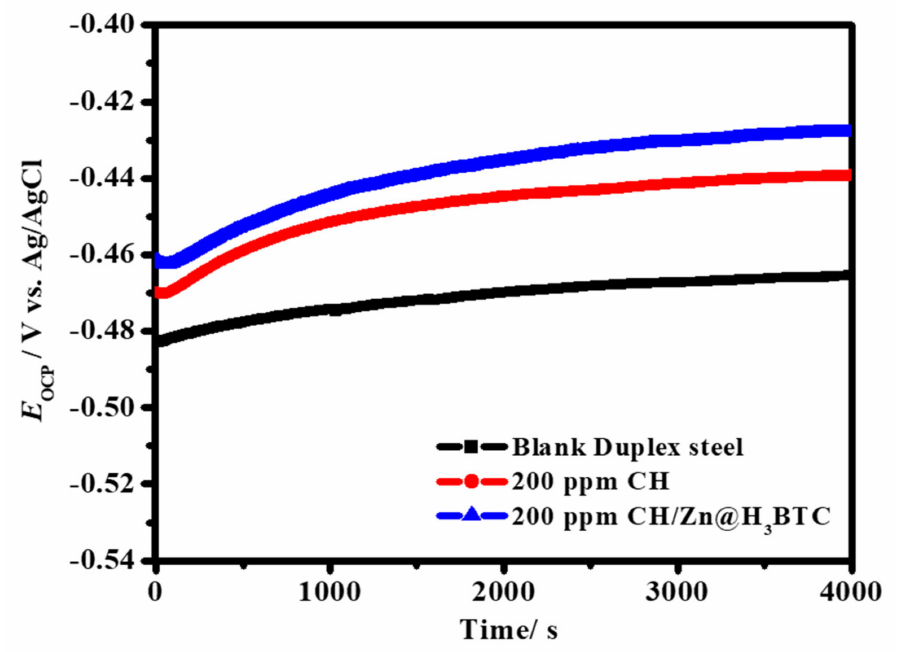
Figure 5. E OCP versus t profiles for duplex steel in a 2.0 M sulfuric acid medium without and with 200 ppm CH and CH/Zn@H 3